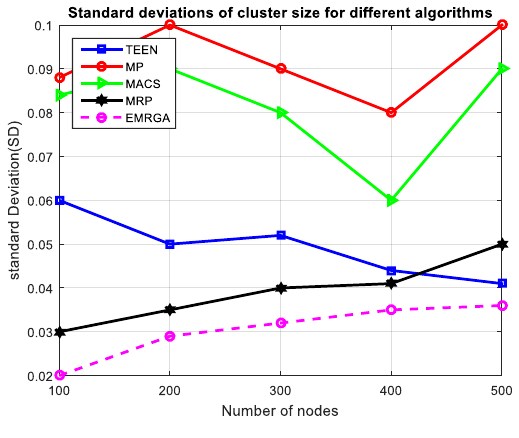
Figure 9. Standarddeviation. Figure 10. Energy consumption.